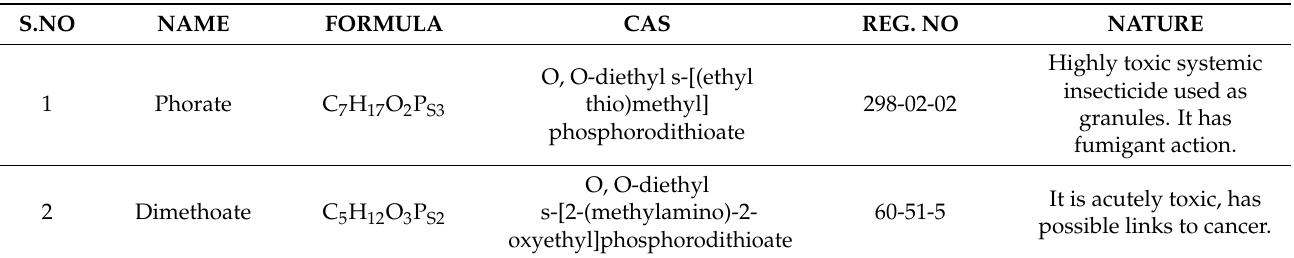
Table 1. Phorate and